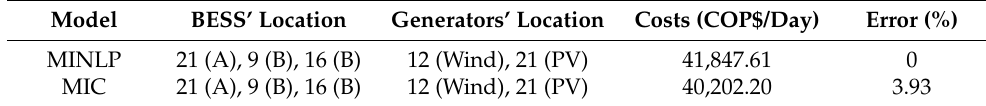
Table 7. Numerical results for the MIC and MINLP models in Case